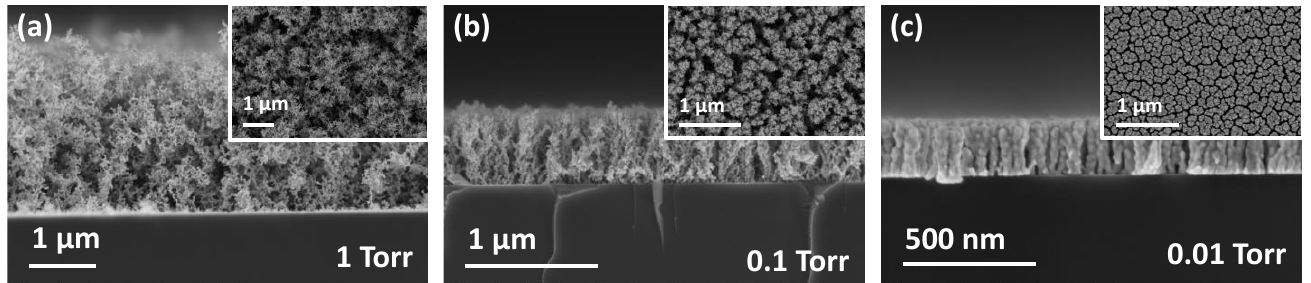
Figure 1. Porous structure of Au thin films obtained by nucleation and growth control during high-pressure thermal evaporation process at different pressure: ( a ) Fractal-like nanoporous Au thin film grown at 1 Torr; ( b ) intermediate nanoporous Au thin film grown at 0.1 Torr; ( c ) columnar Au thin film grown at 0.01 Torr.